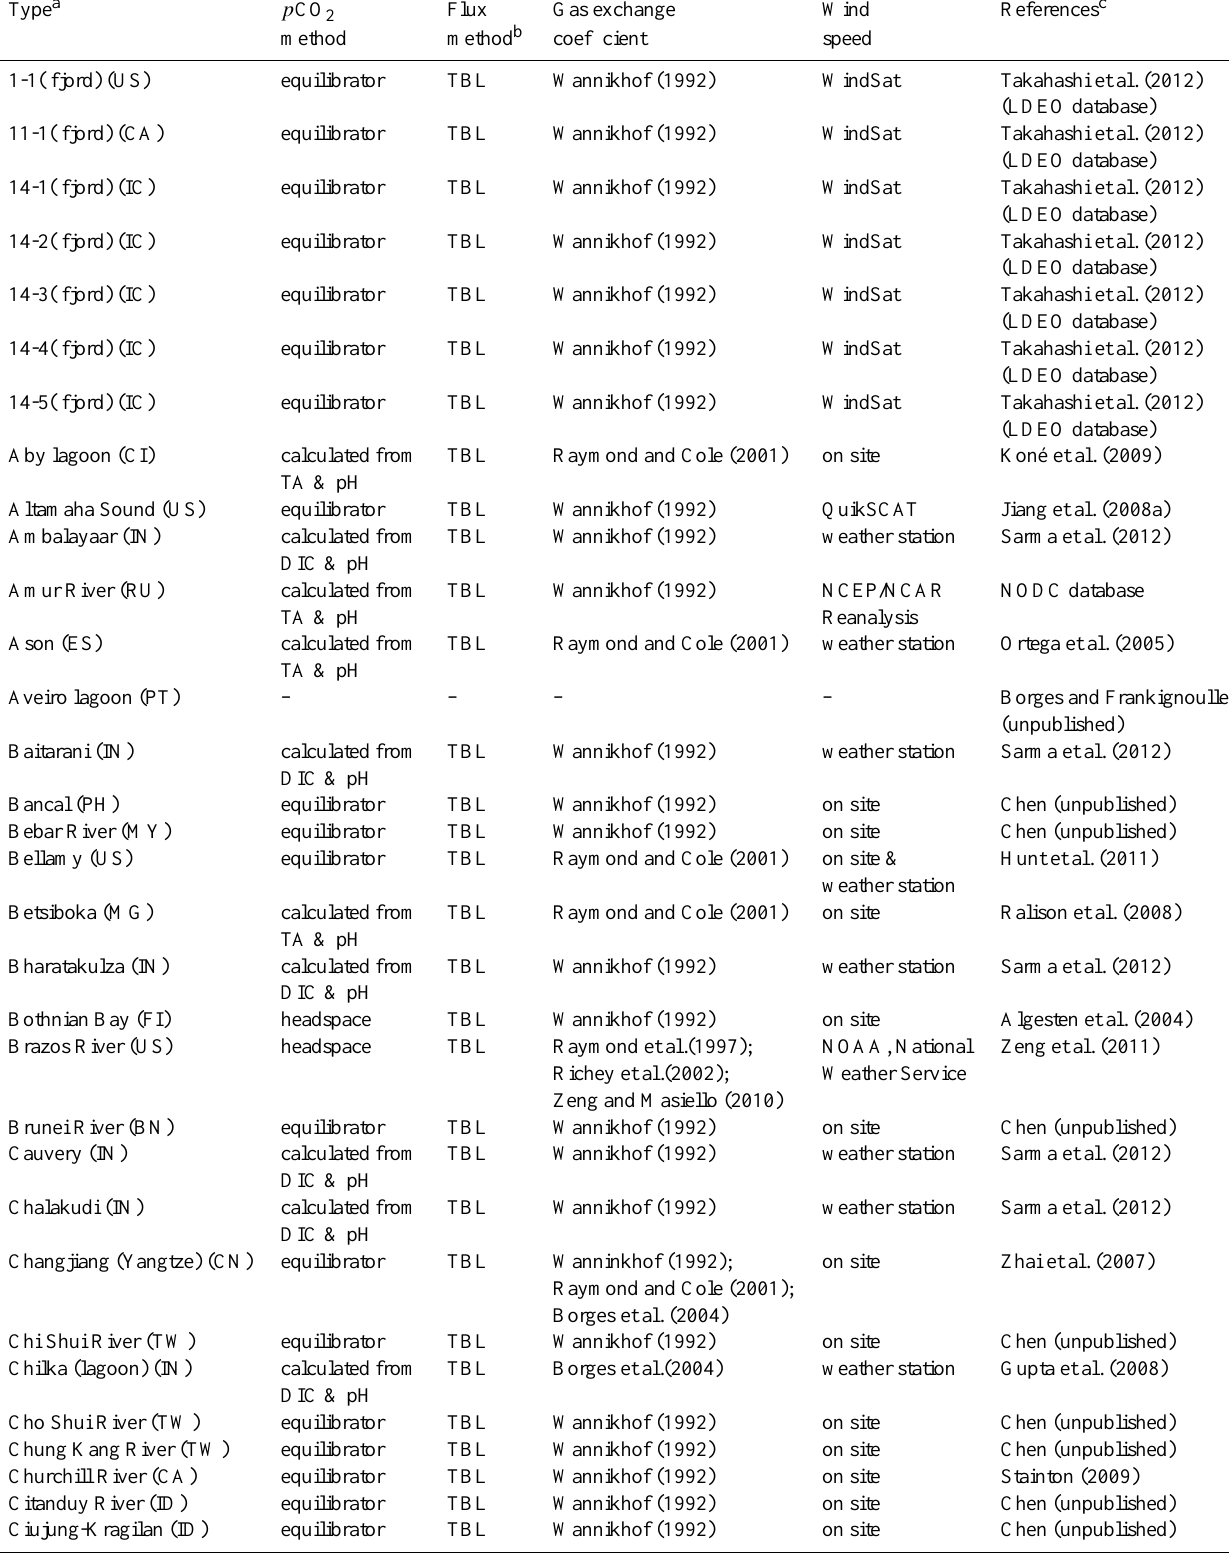
Table 2. The p CO 2 and flux method, the gas exchange coefficient and the wind speed in the world’s